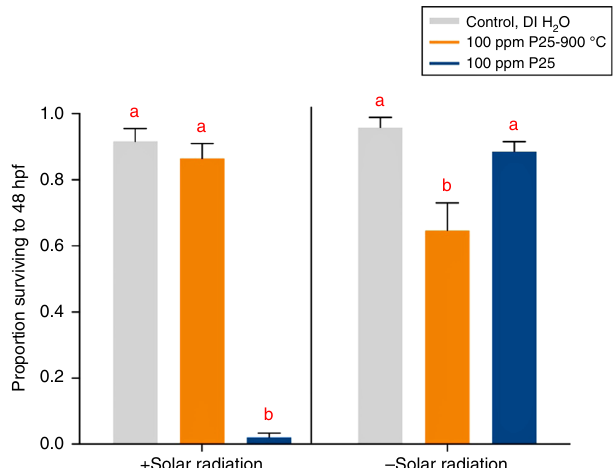
Fig. 6 P25 or P25-900 °C nanoparticle toxicity when exposed to dechorionated zebra fi sh embryos. All measurements are made 48 h post fertilization (hpf), under co-exposure to simulated solar radiation, SSR (labeled “ + Solar radiation ” ) or without SSR co-exposure (labeled “ -Solar radiation ” ). Titania (P25 or P25-900 °C) exposures were made at 100 ppm, and compared to control groups at 0 ppm titania. Letters “ a ” and “ b ” signify statistically different responses among nanomaterial treatments within the + SSR and − SSR co-exposure groups ( P < 0.05), with error bars depicted here as plus or minus the standard error of the Figure 6 shows dechorionated zebra fi sh embryo survival at 48 h post fertilization (hpf) in replicates exposed to P25 nanoparticles with and without concurrent simulated solar radiation (SSR), at titania concentrations of 100 ppm, as well as control groups with no titania exposure, all this modeled after Bar-Ilan et al. 29 for the sake of comparison. The only difference between the Bar-Ilan et al. study and the present one is that exposure to P25-900 °C nanoparticles was also carried out.